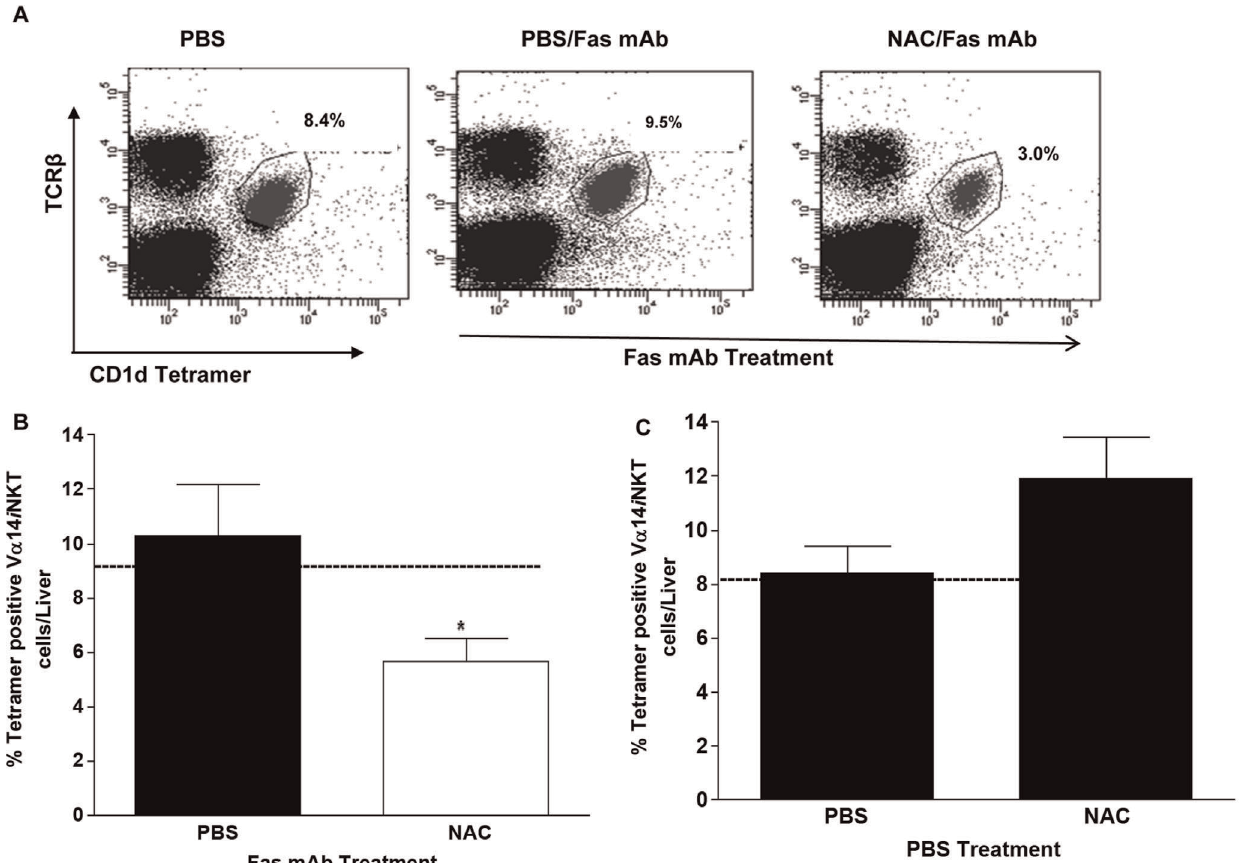
Figure 4. Effect of NAC treatment on intrahepatic V a 14 i NKT cell accumulation during Fas mAb-induced FLF. ( a ) Representative FACS dot plot of V a 14 i NKT cells levels in the liver after PBS or NAC treatment during Fas mAb-induced FLF. ( b ) FACS analysis of V a 14 i NKT cells level in the liver after PBS or NAC treatment in response to Fas mAb-induced FLF. ( c ) FACS analysis of V a 14 i NKT cells level in the liver after PBS or NAC treatment only (i.e. in the absence of agonistic Fas mAb). Results in b and c are shown as mean 6 s.e.m with n =4–6 mice/group with * P , 0.05 by Student’s unpaired t test. All experiments were conducted twice. Broken lines denote levels in untreated mice.